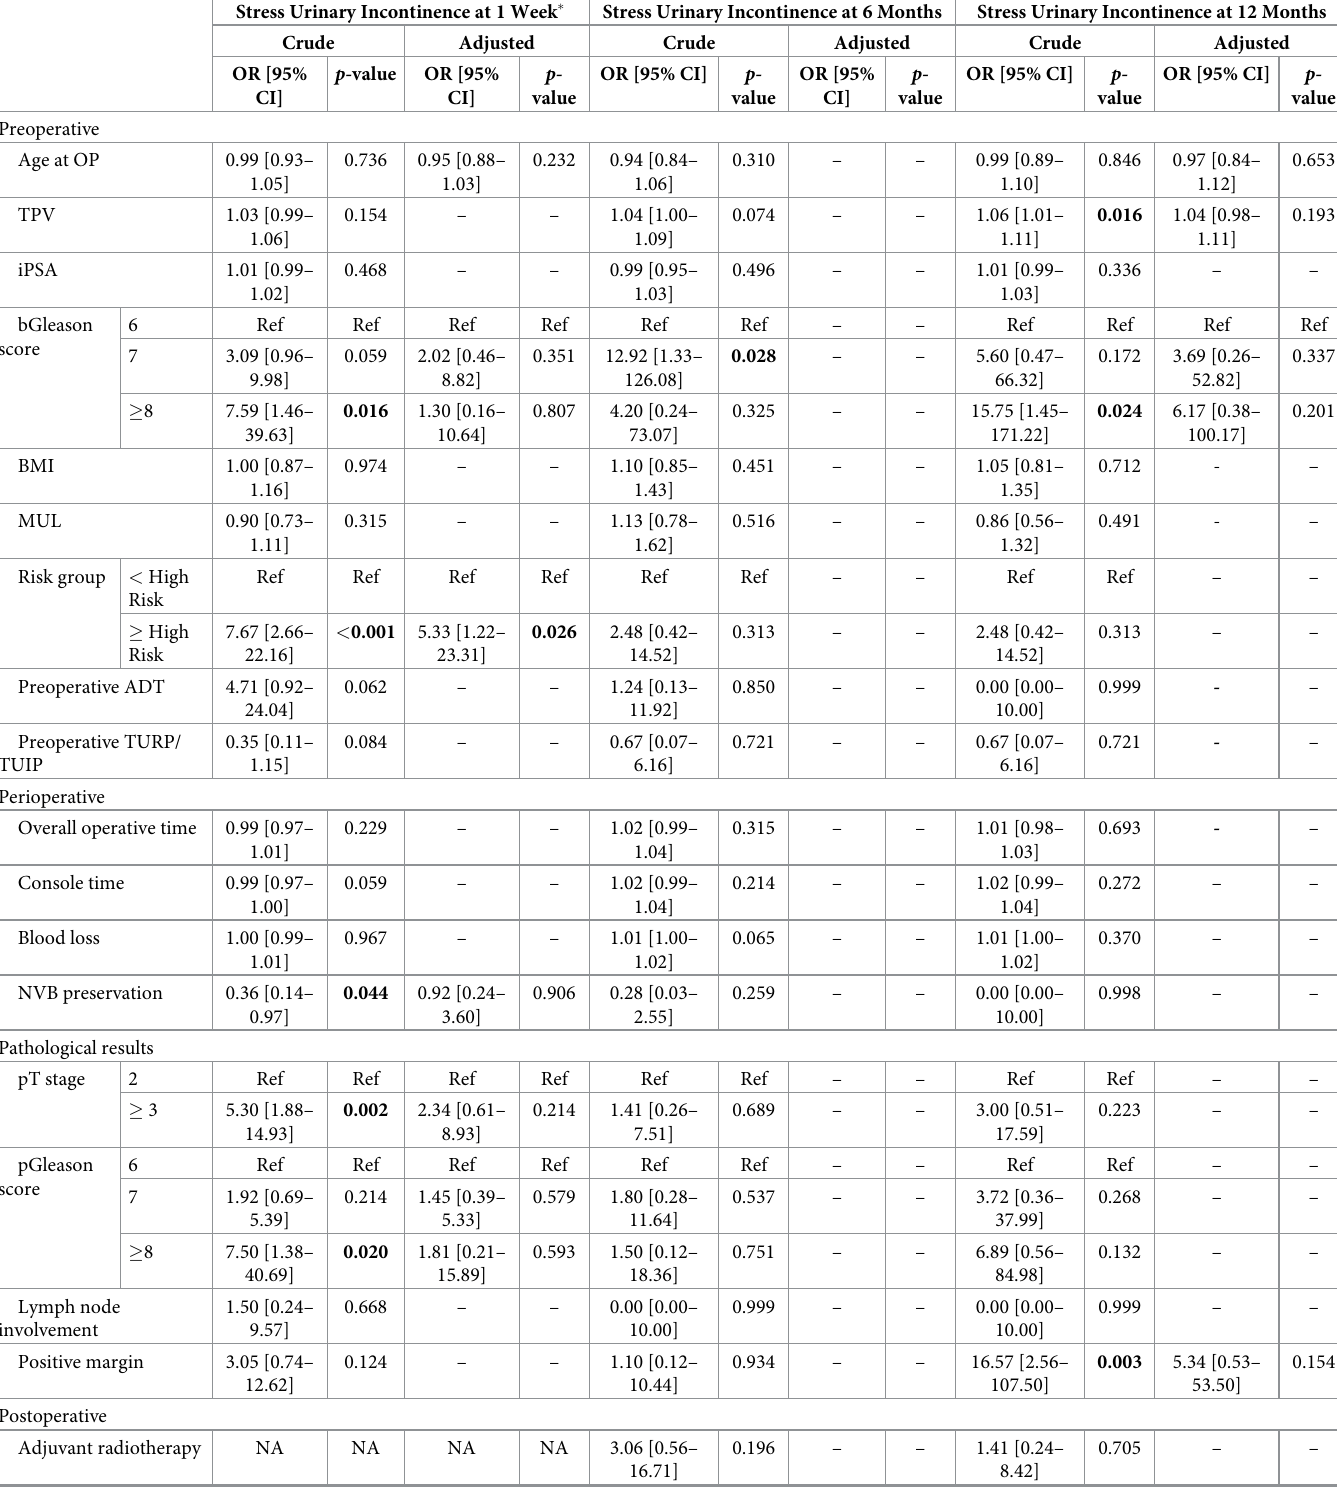
Table 2. Univariable and multivariable logistic regression models of risks of stress urinary incontinence in prostate cancer patients with functional documentation (n = 71) 1 week, 6 months, and 12 months after robot-assisted radical